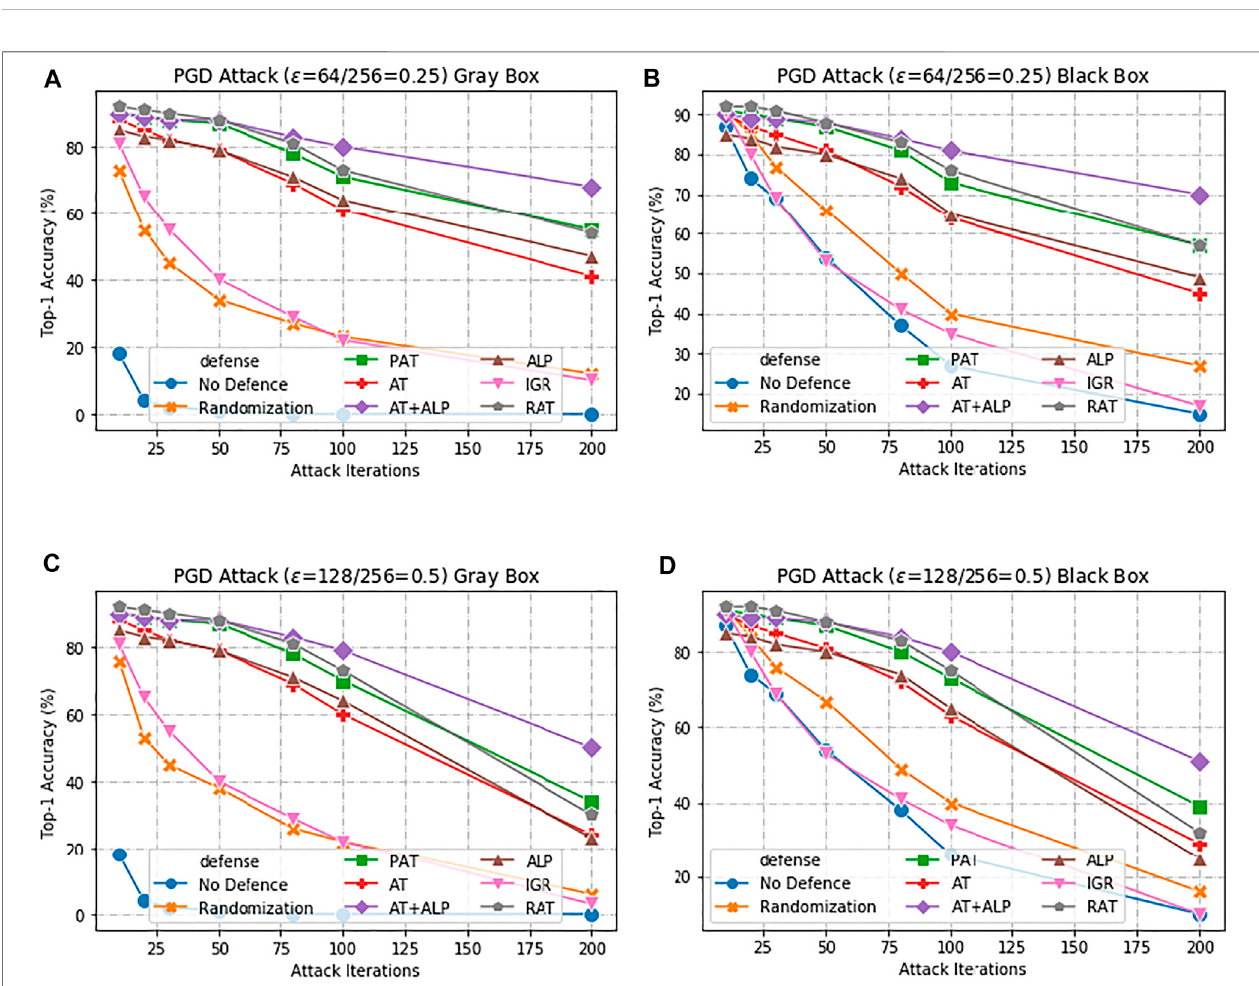
FIGURE3| Defenseagainstgray-boxandblack-boxattackson17FlowerCategoryDatabase. (A,C) showsresultsagainstagray-boxPGDattacker with10 – 200 attack iterations. (B,D) shows results against a black-box PGD attacker with 10 – 200 attack iterations. The maximum perturbation is ϵ ∈ {0.25, 0.5}, i.e., L ∞ ∈ {0.25, 0.5}.Our AT + ALP (purple line) outperform the state-of-the-art in adversarial robustness against highly challenging gray-box and black-box PGD attacks.